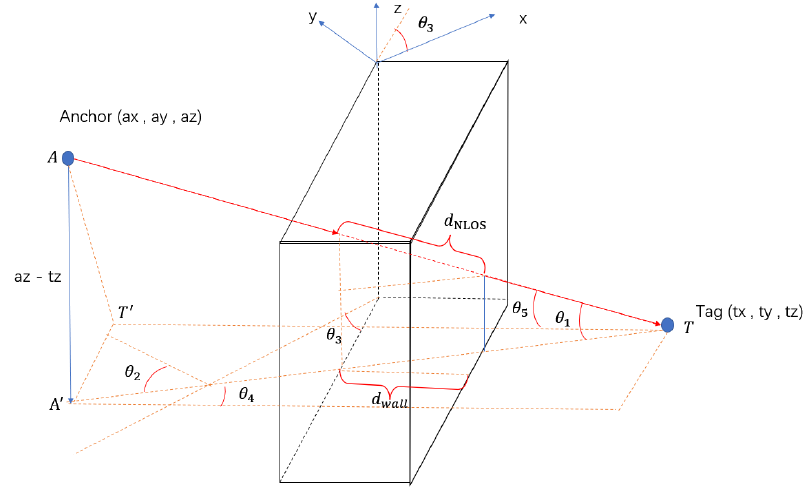
Figure 4. Delay model for a wall.